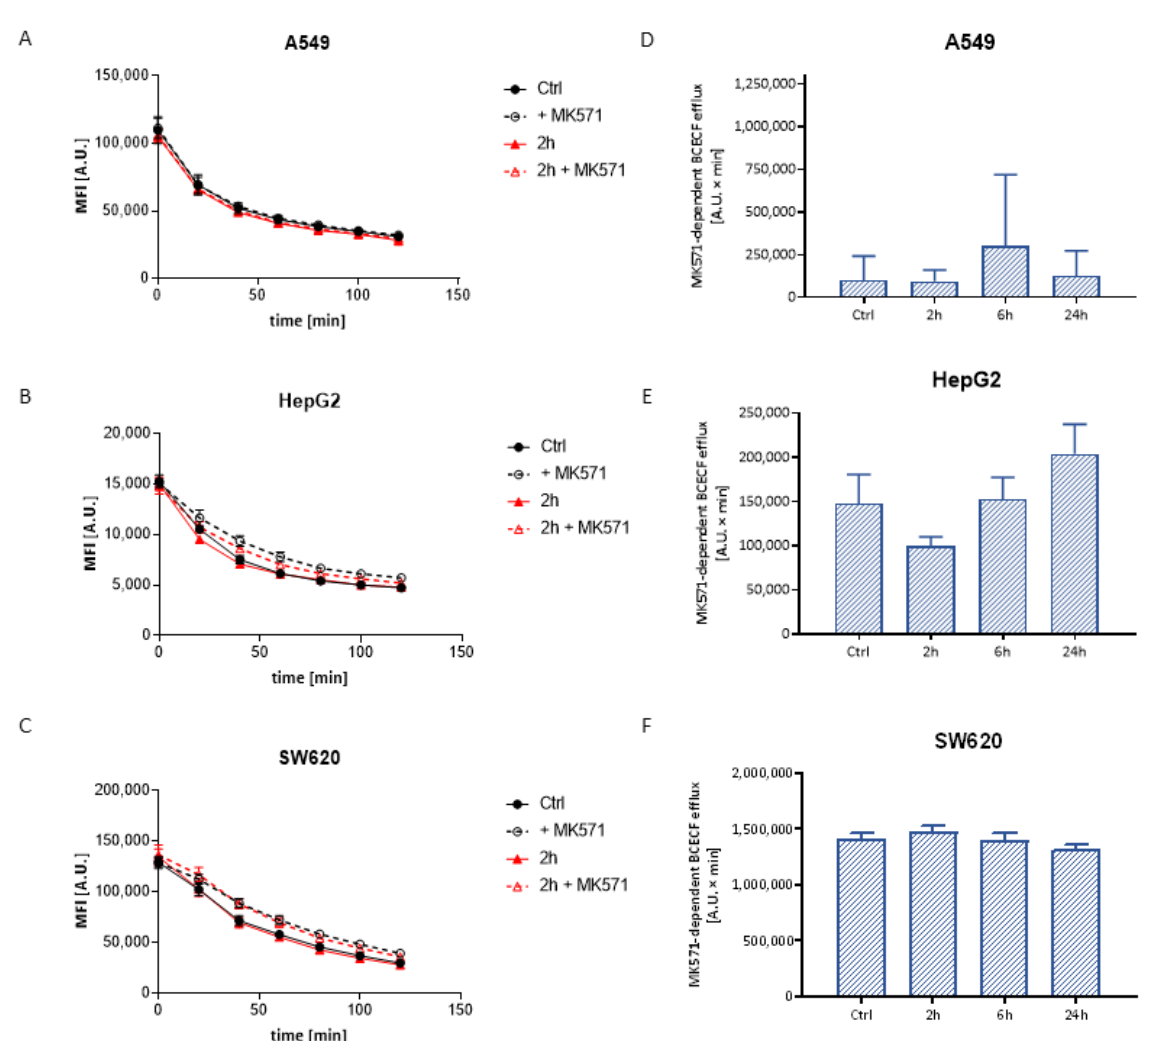
Figure 4. Illustrative plot of intracellular BCECF efflux versus time in A549 ( A ), HepG2 ( B ) and SW620 ( C ) cells treated with Ag20 in the presence and absence of MK571. MK571-dependent BCECF efflux in A549 ( D ), HepG2 ( E ) and SW620 ( F ) cell lines treated for 2, 6 and 24 h with 50 μg/cm 3 Ag20 expressed as the area under the curve of the fluorescence decay over time. One-way ANOVA and Dunnett’s post hoc test were used. Data expressed as arithmetic mean ± SD; n = 3.